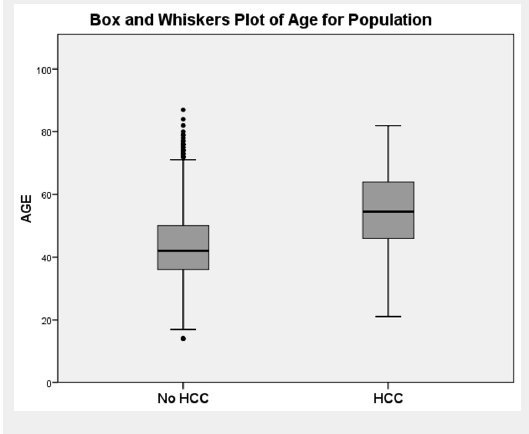
Figure 2 Box and whiskers plot of age for non-HCC and HCC group.